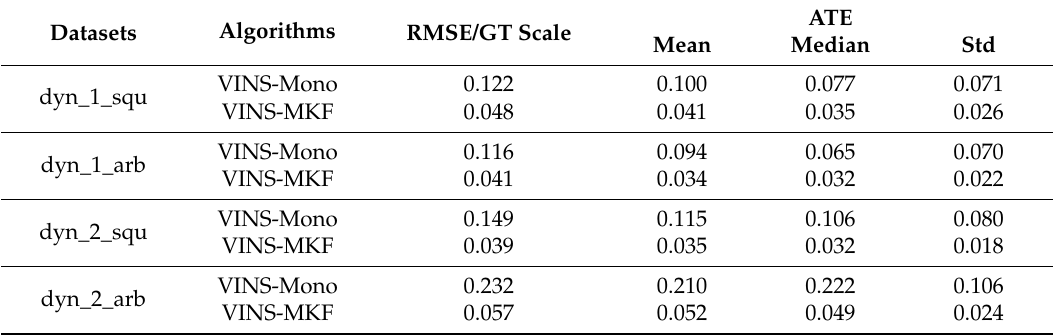
Table 6. The root mean square error (RMSE/m) and absolute trajectory error (ATE/m) results of VINS-Mono and VINS-MKF on home-made